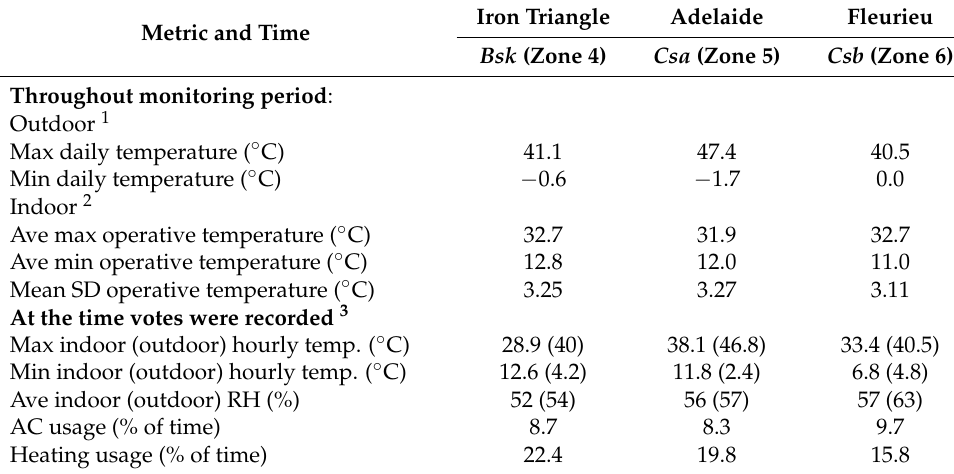
Table 2. Descriptive statistics for maximum (max) and minimum (min) temperatures ( ◦ C) during the period homes were monitored and when occupants responded to the survey, showing the amount of time cooling and heating were used by occupants. Iron Triangle Adelaide Fleurieu Metric and Time Bsk (Zone